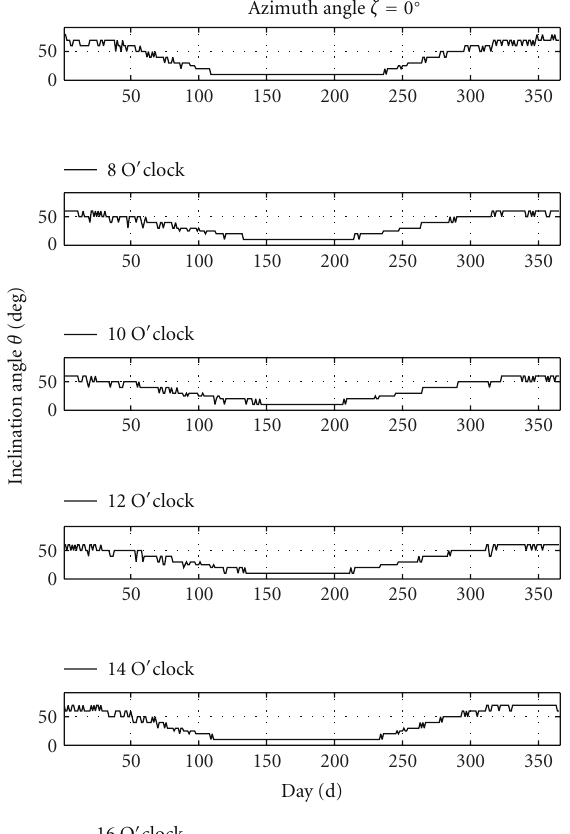
Figure 4: Optimal inclination angles θ for di ff erent times in the day over all the year while the azimuth angle is set to ζ = 0 ◦